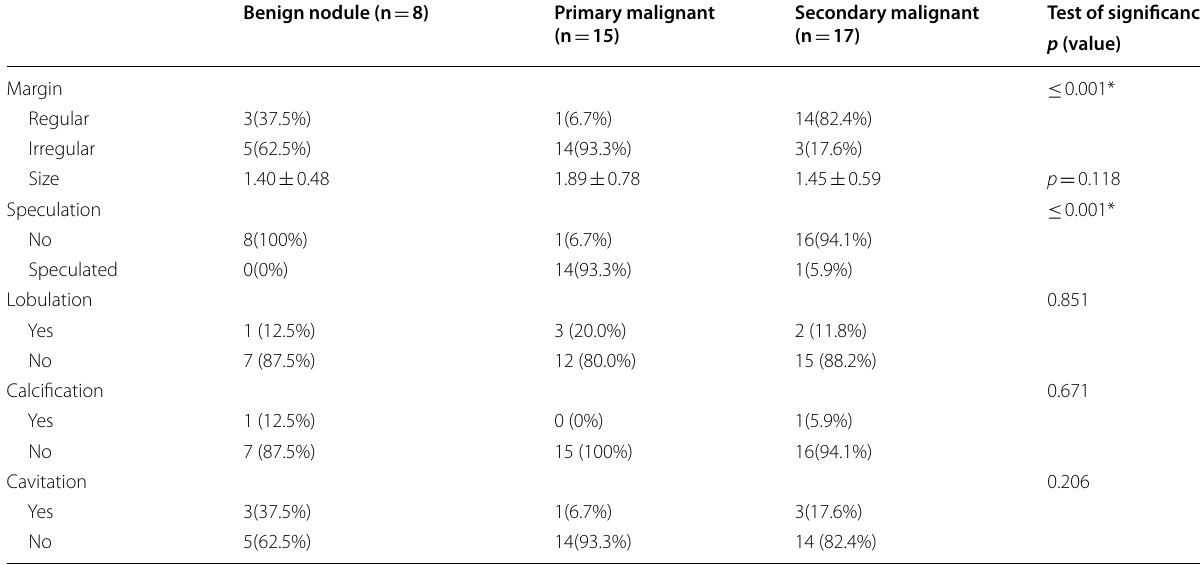
Table 2 CT morphological characterization of benign, primary and secondary malignant pulmonary